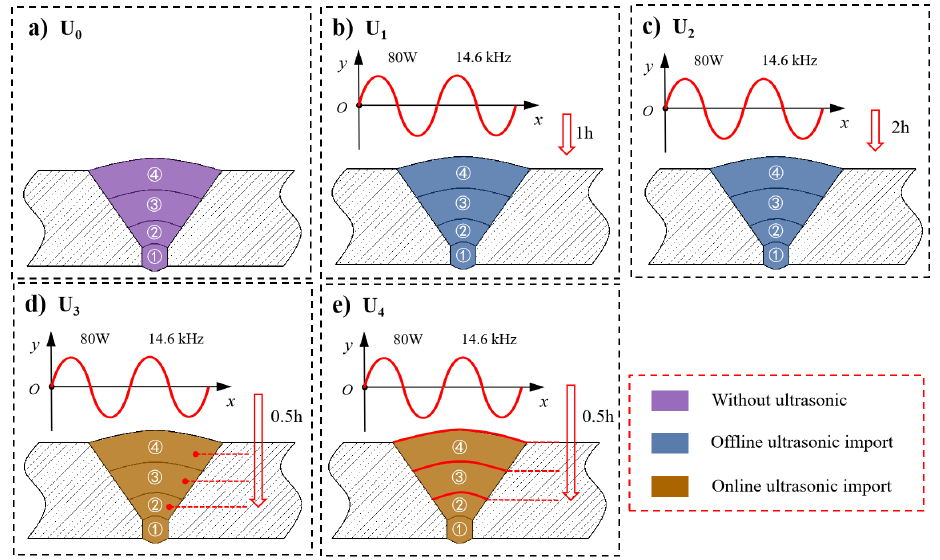
Figure 6. Scheme of the comparison group: ( a – e ) U 0 –U 4 , respectively. To ensure the validity of the comparison sample data, the 0° starting points and cir- cumferential 330° points of the above five groups of welding samples were selected as the sampling center points of tensile specimens and metallographic specimens. The shape and specifications of the specimens are shown in Figure 7. X-rays were used to detect the internal defects of the samples, which were then cut by WEDM to obtain the specimens after no defects were detected. The surfaces of the metallographic specimens were pol- ished and corroded, and then they were microstructurally observed by OLYMPUS GX51 microscopy(OLYMPUS, Tokyo, Japan). The tensile test was carried out at the speed of 3 mm/min based on ISO4136:2022 by using a SANS-XYB305C tensile testing machine(SANS testing machine co.,LTD, Shenzhen, China). The hardness test was carried out by a